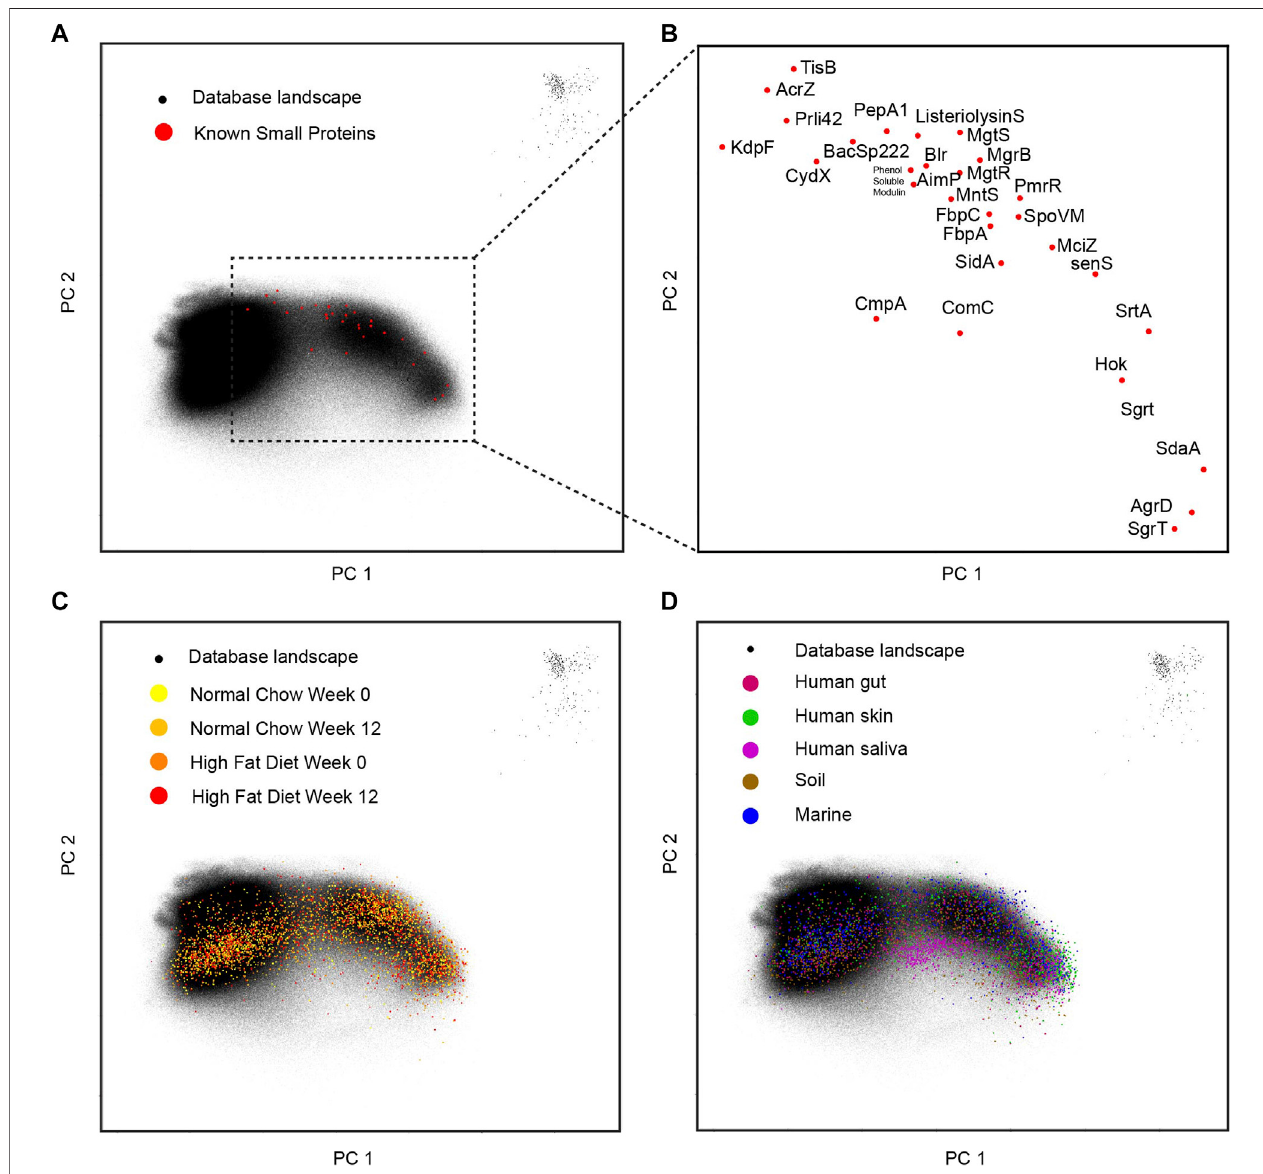
FIGURE 4 | Landscape for small proteins. (A) The database with 29-known small proteins overlaid. (B) The zoomed-in display for 29-known small proteins in the two-dimensional space. (C) The different mice gut samples overlay with the database landscape. (D) The human and environmental samples overlay with the database